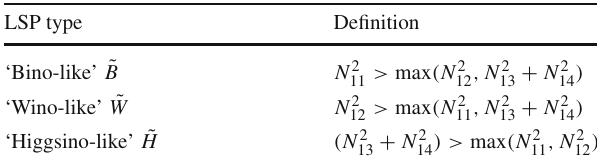
Table 2 Definition of neutralino ˜ χ 0 the neutralino mixing parameter N ij , the first index denotes the neu- tralino mass eigenstate ˜ χ 0